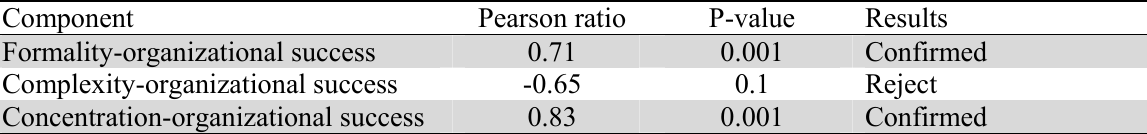
The results of Pearson correlation test Component